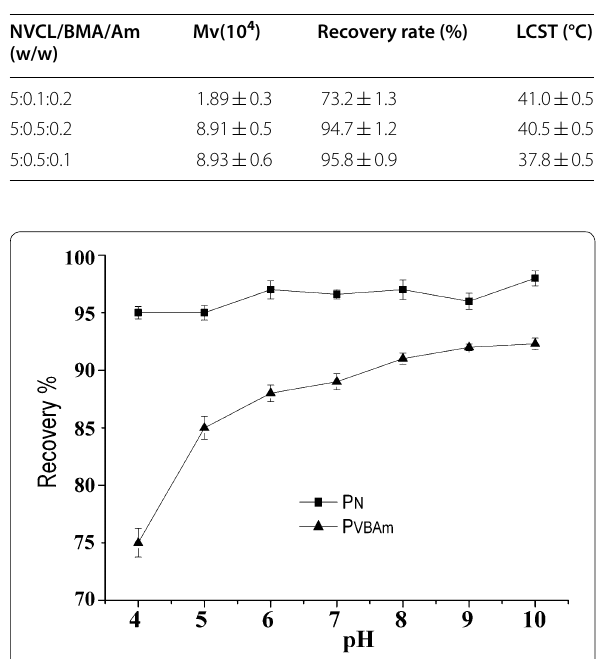
Fig. 5 Effect of pH on the recovery of the two thermo-responsive polymers without salt. The recoveries were carried out at 38 °C for P N and 46 °C for P VBAm